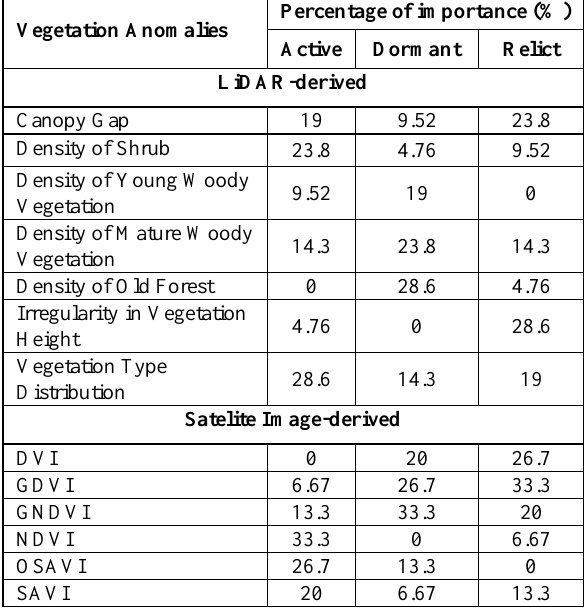
Table 5. Vegetation anomalies index in percentage for all landslide activities Table 5 indicates that vegetation type distribution map is